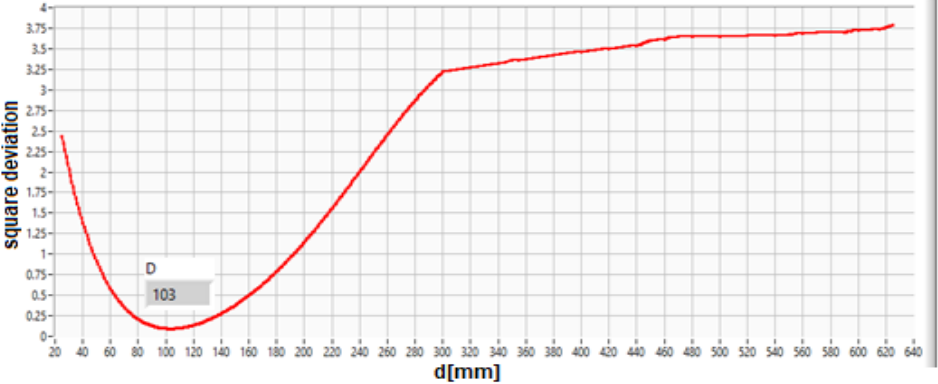
Figure 7. Sharpness cost function for the current measurement (d = 104 mm).